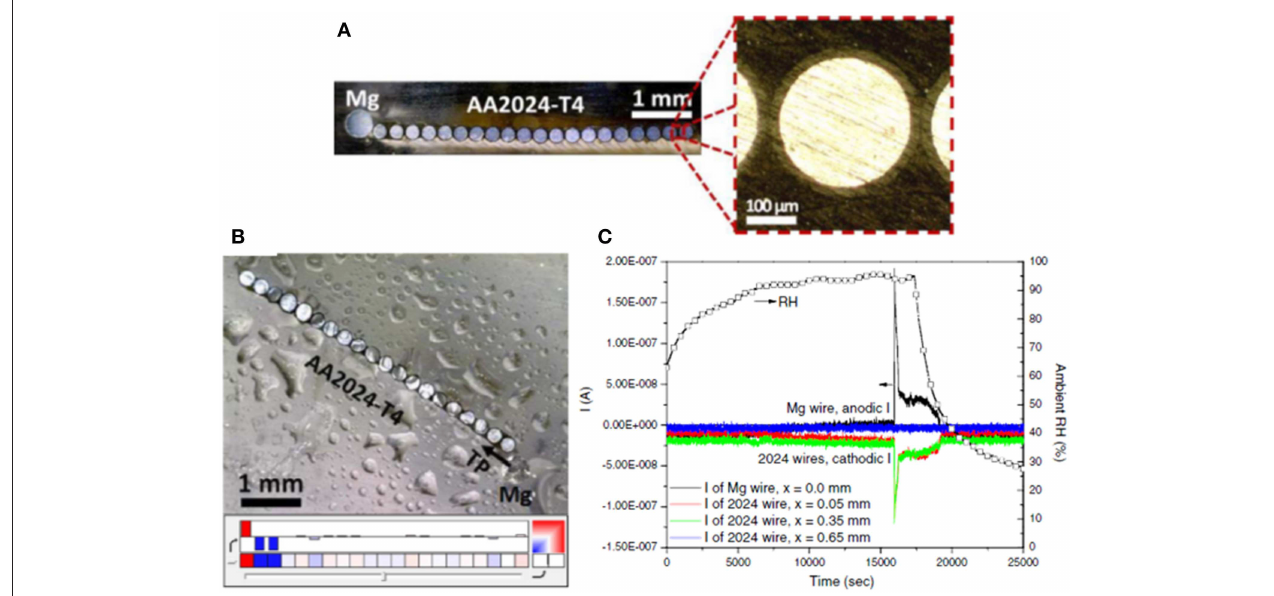
FIGURE 12 | (A) Optical images of a bare Mg/AA2024-T4 microelectrode array used to diagnostically assess the throwing power of Mg over a representative bare AA2024-T4 scratch in an RH controlled cabinet ( Feliu et al., 1993b). The Mg electrode is 500 µ m in diameter. The AA2024-T4 electrodes are 254 µ m in diameter insulated by a 25 µ m thick polyimide coating with a mean electrode spacing of 50 µ m. The total width of all of the AA2024-T4 microelectrodes is approximately 5750 µ m and the total area ratio of AA2024:Mg is 5:1. (B) optical image of the bare-Mg/bare AA2024-T4 microelectrode array with 1,000 µ g/cm 2 NaCl deposited by salt spray and allowed to equilibrate at 94% RH for at least 3h. In the color map dark red indicates an anodic current ≥ 1 × 10 − 5 A/cm 2 and dark blue indicates a cathodic current of ≤ -1 × 10 − 5 A/cm 2 . White color indicates a net current of zero. (C) Measured current and RH. Reproduced with permission.